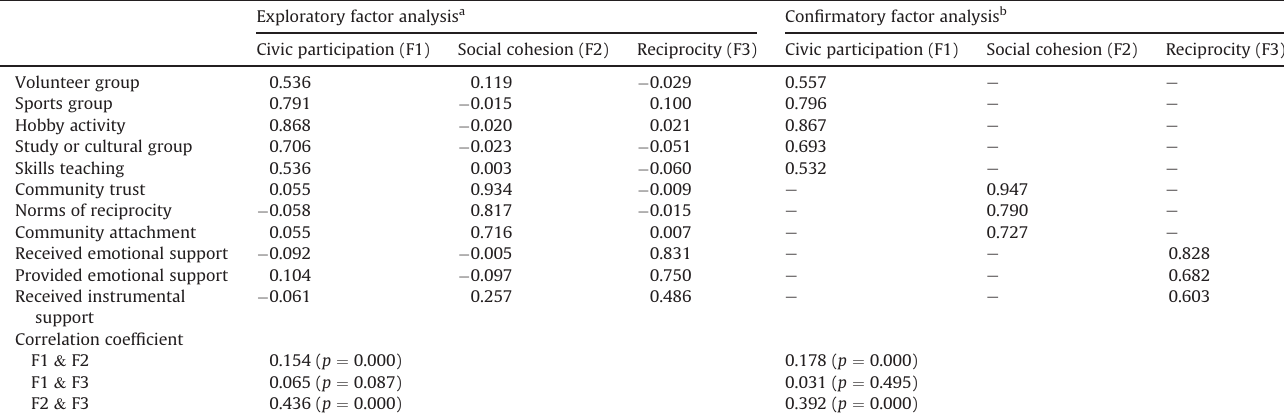
Table 3 Factor loadings of community-level social capital scale.